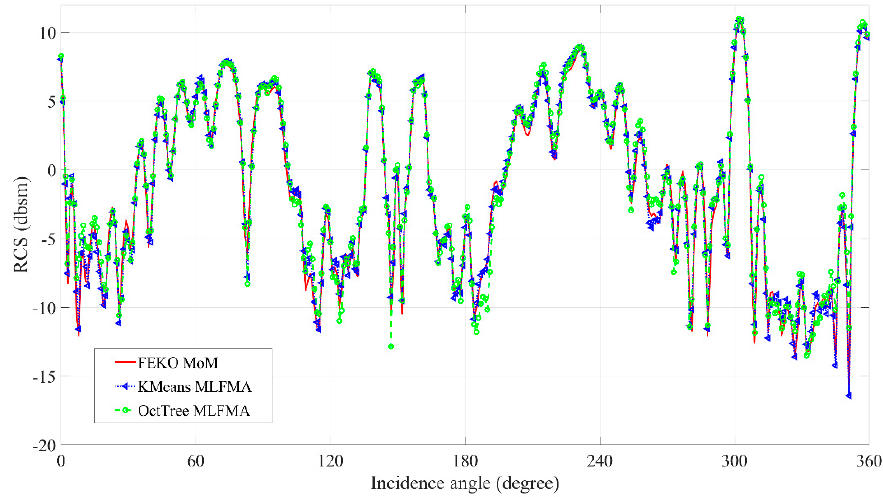
Figure 12. Monostatic RCS results of the realistic stealth CAD model.